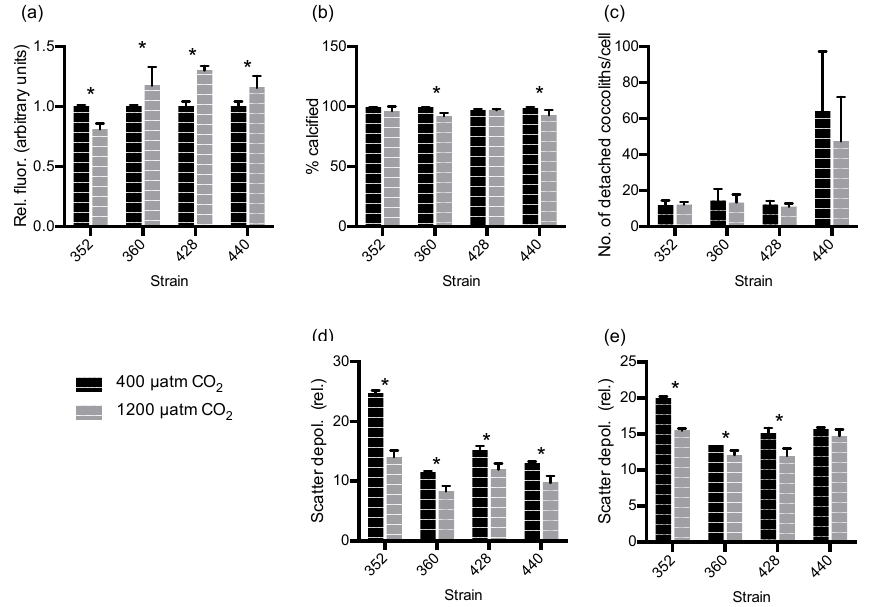
Figure 7. Effects of high-CO 2 treatment on flow cytometric properties of cells and detached coccoliths for all treatments and strains. Strain CHC342 is not shown because samples were lost in transit between labs. Shown are the relative fluorescence (compared to control treat- ment) (a) , the proportion of cells that were calcified (b) , abundance of detached coccoliths divided by cell abundance (c) , relative FSC (scatter depolarization) of cells (d) , and detached coccoliths (e) . Fluorescence and FSC units are relative and the voltage for the detector for FSC perpendicularly polarized was 2-fold higher, resulting in a sensitivity approximately 2 orders of magnitude higher. Scatter depolarization was calculated for every particle as the ratio of FSC with polarizations perpendicular vs. parallel to the laser, normalized by the same ratio for non-optically active particles within the same sample. The ∗ indicates significant difference ( p < 0 . 05) in pairwise comparison between the two CO 2 treatments for a given strain, as judged by Sidak post hoc testing with correction for multiple comparison. Table 5. Global two-way ANOVA results for flow cytometric parameters. The percentages of calcified cells were expressed as a fraction and arcsine-square-root transformed prior to testing. Rel. red % calcified No. detached Rel. scatter Rel. scatter depol. fluoresce. coccol. depol. cells detached liths Source of variat.